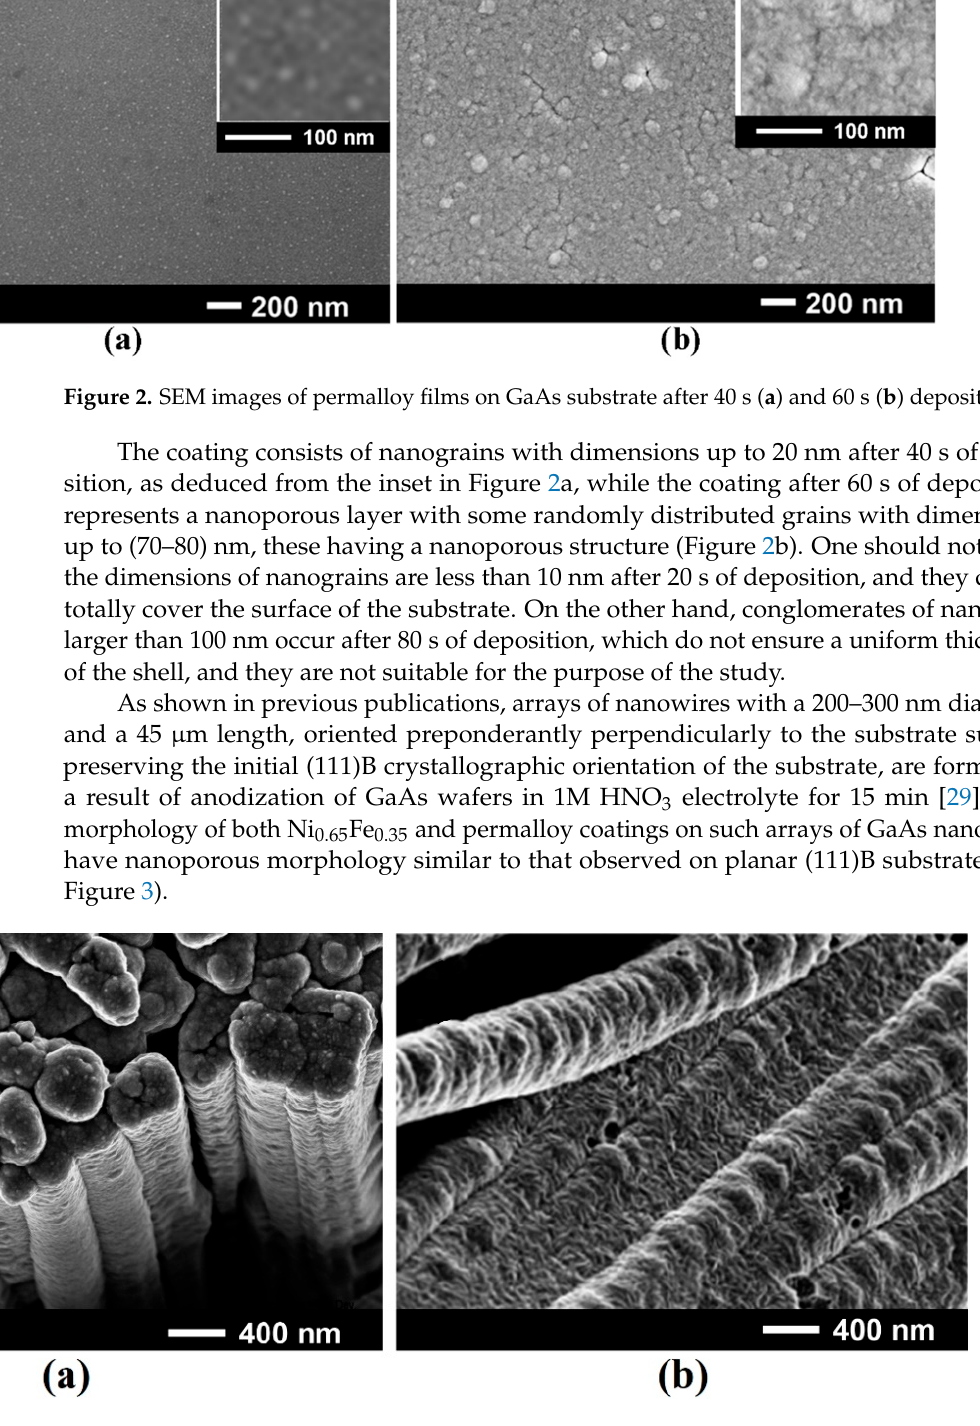
Figure 2. SEM images of permalloy films on GaAs substrate after 40 s ( a ) and 60 s ( b ) deposition.